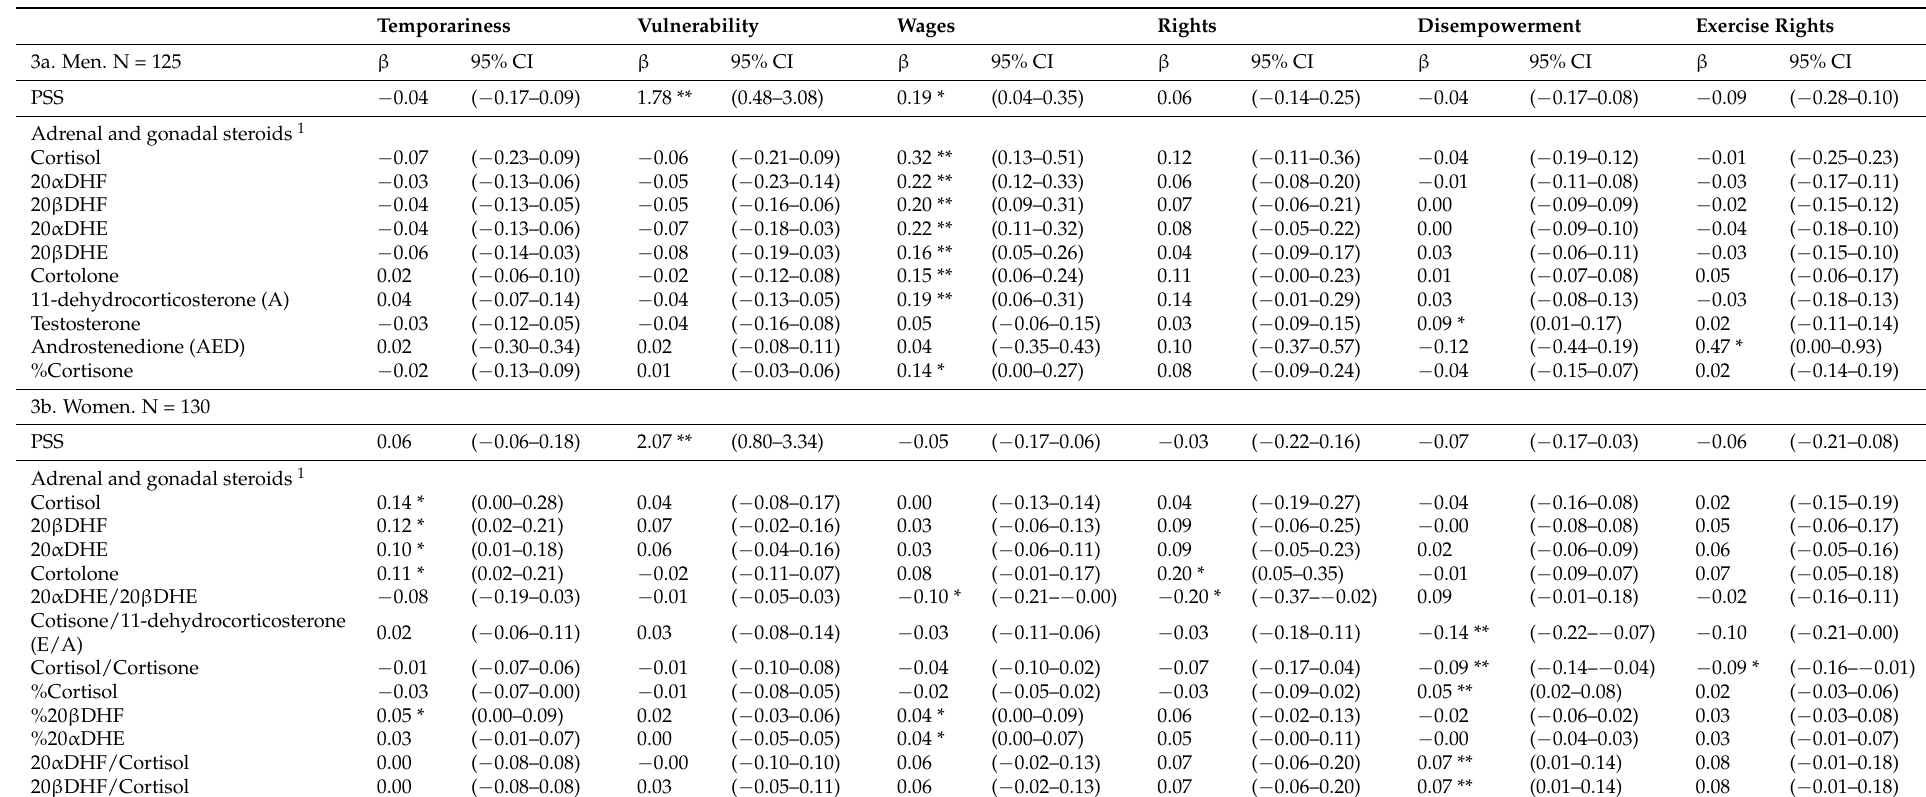
Table 3. Linear regression coefficients and 95% confidence intervals (CI) for Production of Adrenal and Gonadal steroids and EPRES dimensions